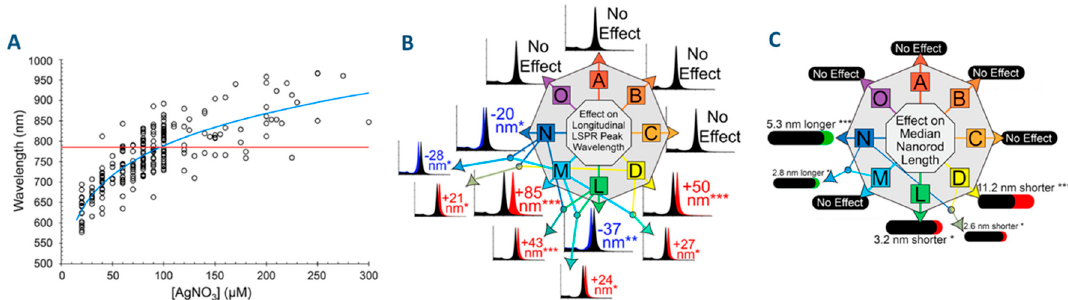
Figure 2. ( A ) Plot of the longitudinal surface plasmon resonance extinction peak wavelength as a function of silver nitrate concentration illustrating the synthesis variation by different individuals produced in the Murphy group over the last half-decade. ( B ) and ( C ) Graphical summary of the significant primary and secondary interaction effects on the l- localized surface plasmon resonance (LSPR) peak wavelength and of the median nanorod length: Amount of NaBH 4 (A), stirring rate of the seed solution (B), age of seed solution (C), amount of seed (D), temperature (L), amount of silver (M), amount of ascorbic acid (N), and age of reduced solution (O). P values (***) < 0.001 < (**) < 0.01 < (*) < 0.05 (from variance analysis). Adapted from [40].